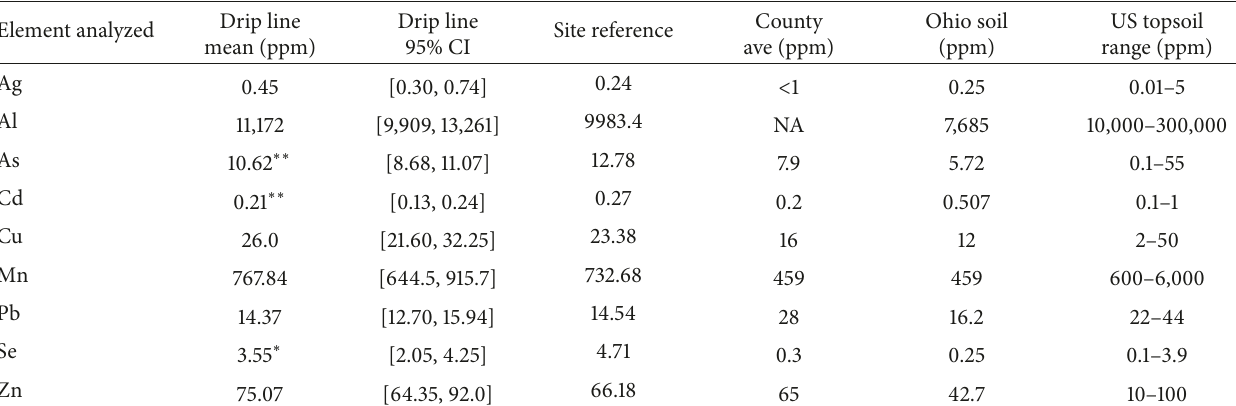
Table 4: Mean concentrations of metals in drip line soils (mean ppm) with 95% confidence intervals (95% CI) compared with reference soils that were collected on site (no chestnuts planted), average background metal concentration in Ohio soils (ppm) [41], averages in Muskingum County [42, 43], and US topsoil ranges [44]. Asterisks ( ∗∗ ) indicate differences at 0.05.